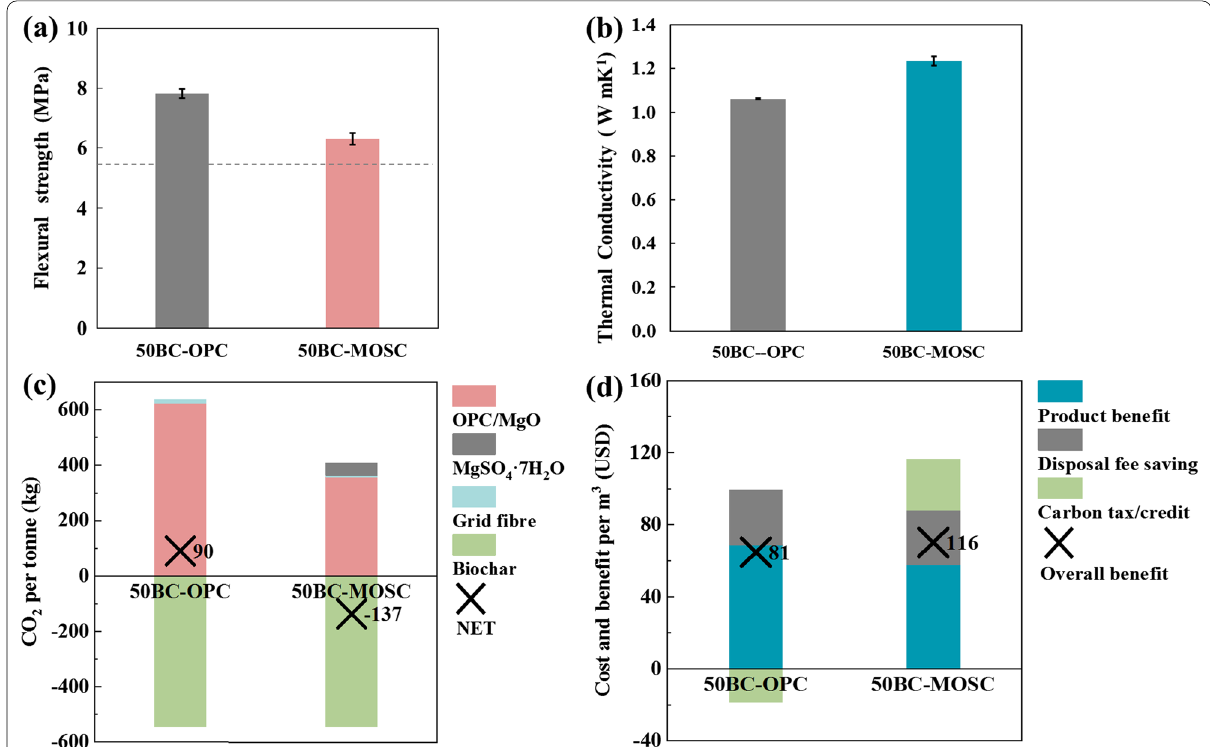
Fig. 6 Flexural strength ( a ), thermal conductivity ( b ), CO 2 emissions ( c ) and cost–benefit analysis ( d ) of biochar